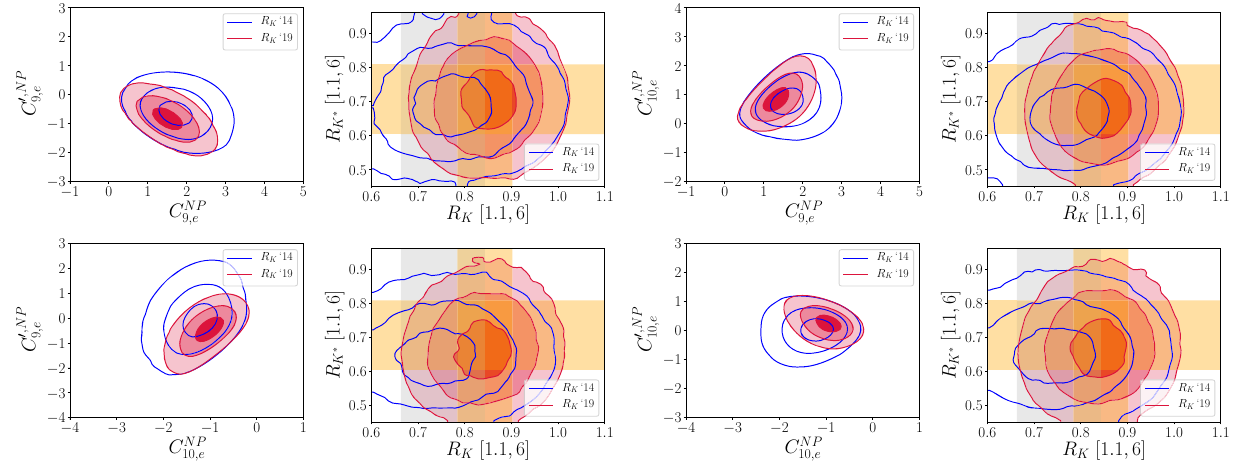
Fig. 6 First row: the first two panels show 2D p.d.f. for the scenario , C (cid:4) , NP ) and the combined 2D p.d.f. of the correspond- with WCs ( C NP 9 , e 9 , e ingresultsfor R K and R K ∗ inthePDDapproaches,followingthecolour